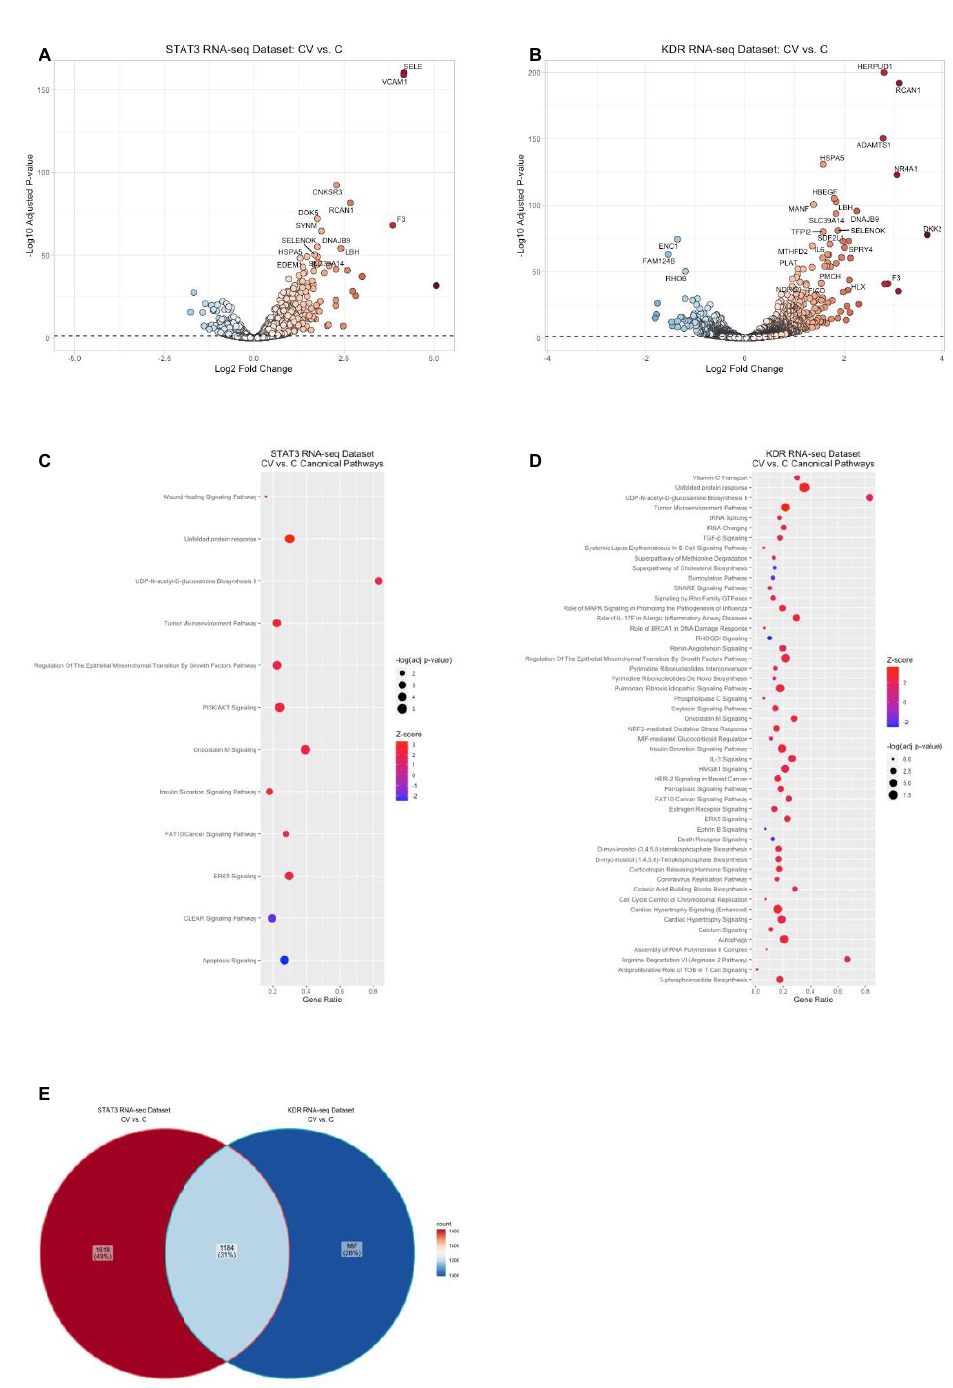
Figure 2. VEGF-mediated gene regulation and pathway enrichment in HRMECs. Visualization of the VEGF-mediated genes (VEGF-treated control siRNA-transfected HRMECs (CV) group compared to the PBS-treated control siRNA-transfected HRMECs (C) group) by volcano plot from ( A ) the STAT3 RNA-seq dataset or ( B ) the KDR RNA-seq dataset (black dashed line represents significance threshold value of − log(adjusted p -value) = 1.30, color gradient visually depicts the fold of gene upregulation (red) and downregulation (blue) in the CV group compared to the C group); bubble plots depicting the significantly enriched and significantly activated or inactivated pathways associated with the VEGF-mediated genes from ( C ) the STAT3 RNA-seq data or ( D ) the KDR RNA-seq dataset (size of bubble directly correlates with the significance of pathway enrichment, color gradient visually depicts the predicted strength of activation (red) or inhibition (blue) of enriched pathways by